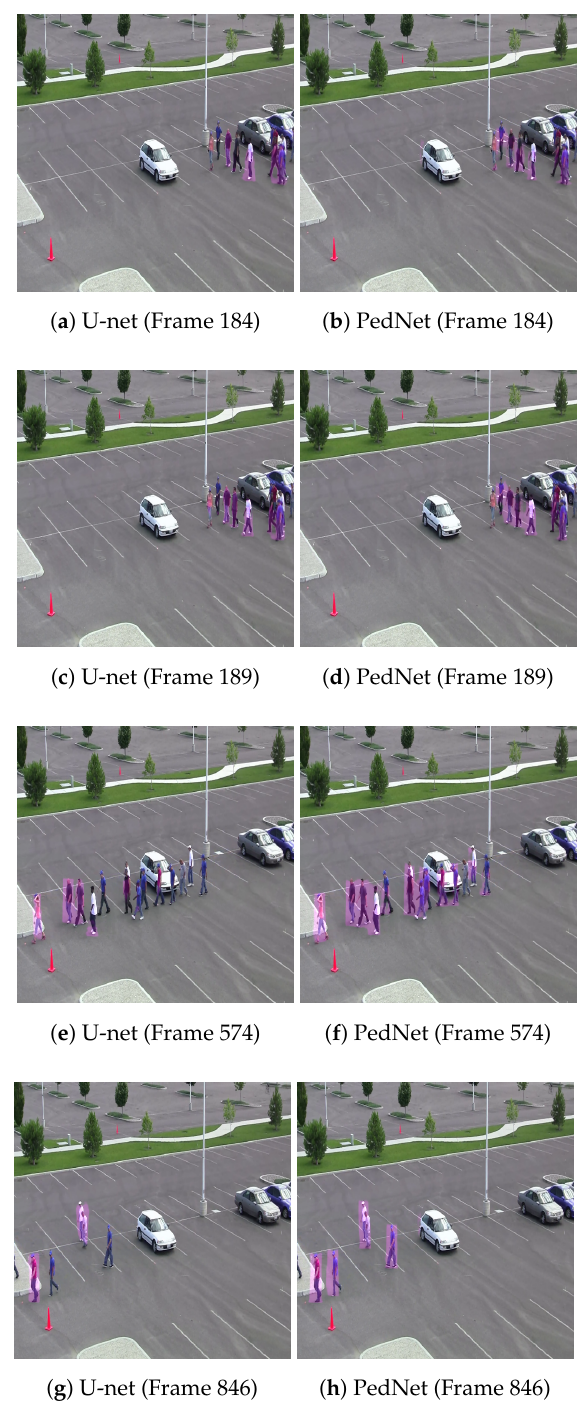
Figure 7. U-net [5] and PedNet are trained on the training datasets. The first column shows the result of U-net while the second column shows the result of PedNet. Even though PedNet has never seen Parking-lot [44,45] dataset, it gives better segmentation